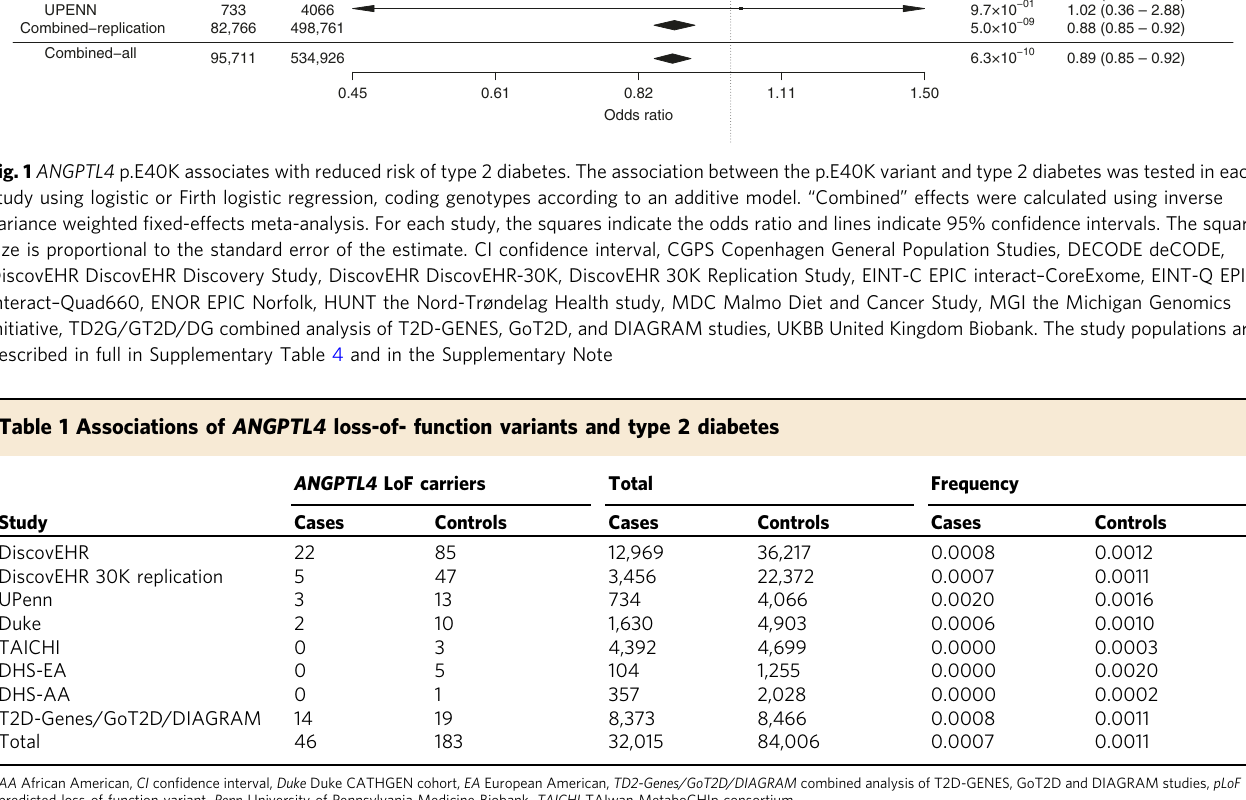
(Table 1). We used a two-sided exact conditional test to combine the counts across studies given the low number of type 2 diabetes cases co-occurring with ANGPTL4 pLoFs, fi nding 29% lower odds of type 2 diabetes among carriers of pLoF variants (OR 0.71,